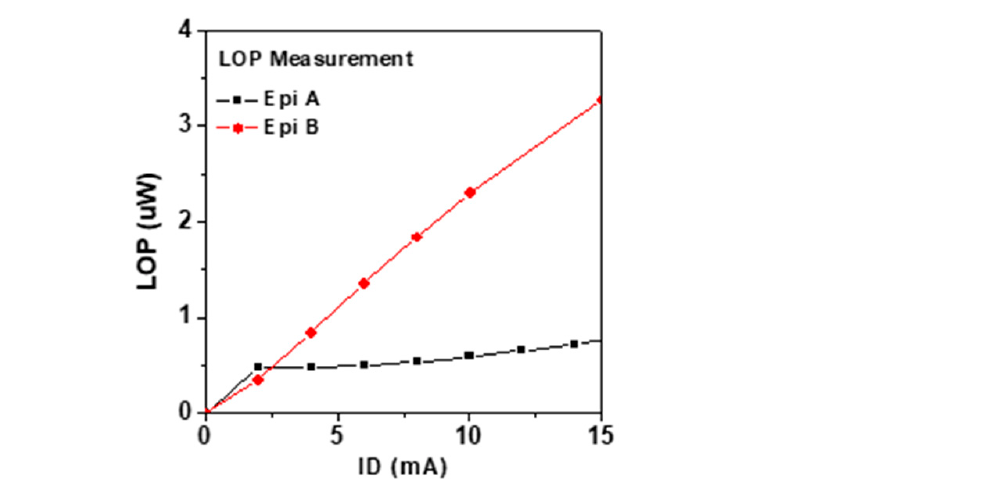
Figure 6. The characteristic of light output power versus I D measured on LE-HEMTs on two epitaxy structures.